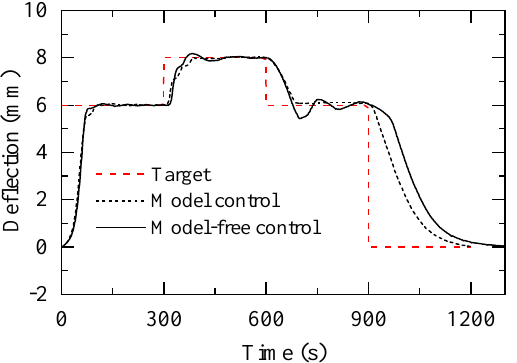
Figure 20. Comparison of control with and without a model.